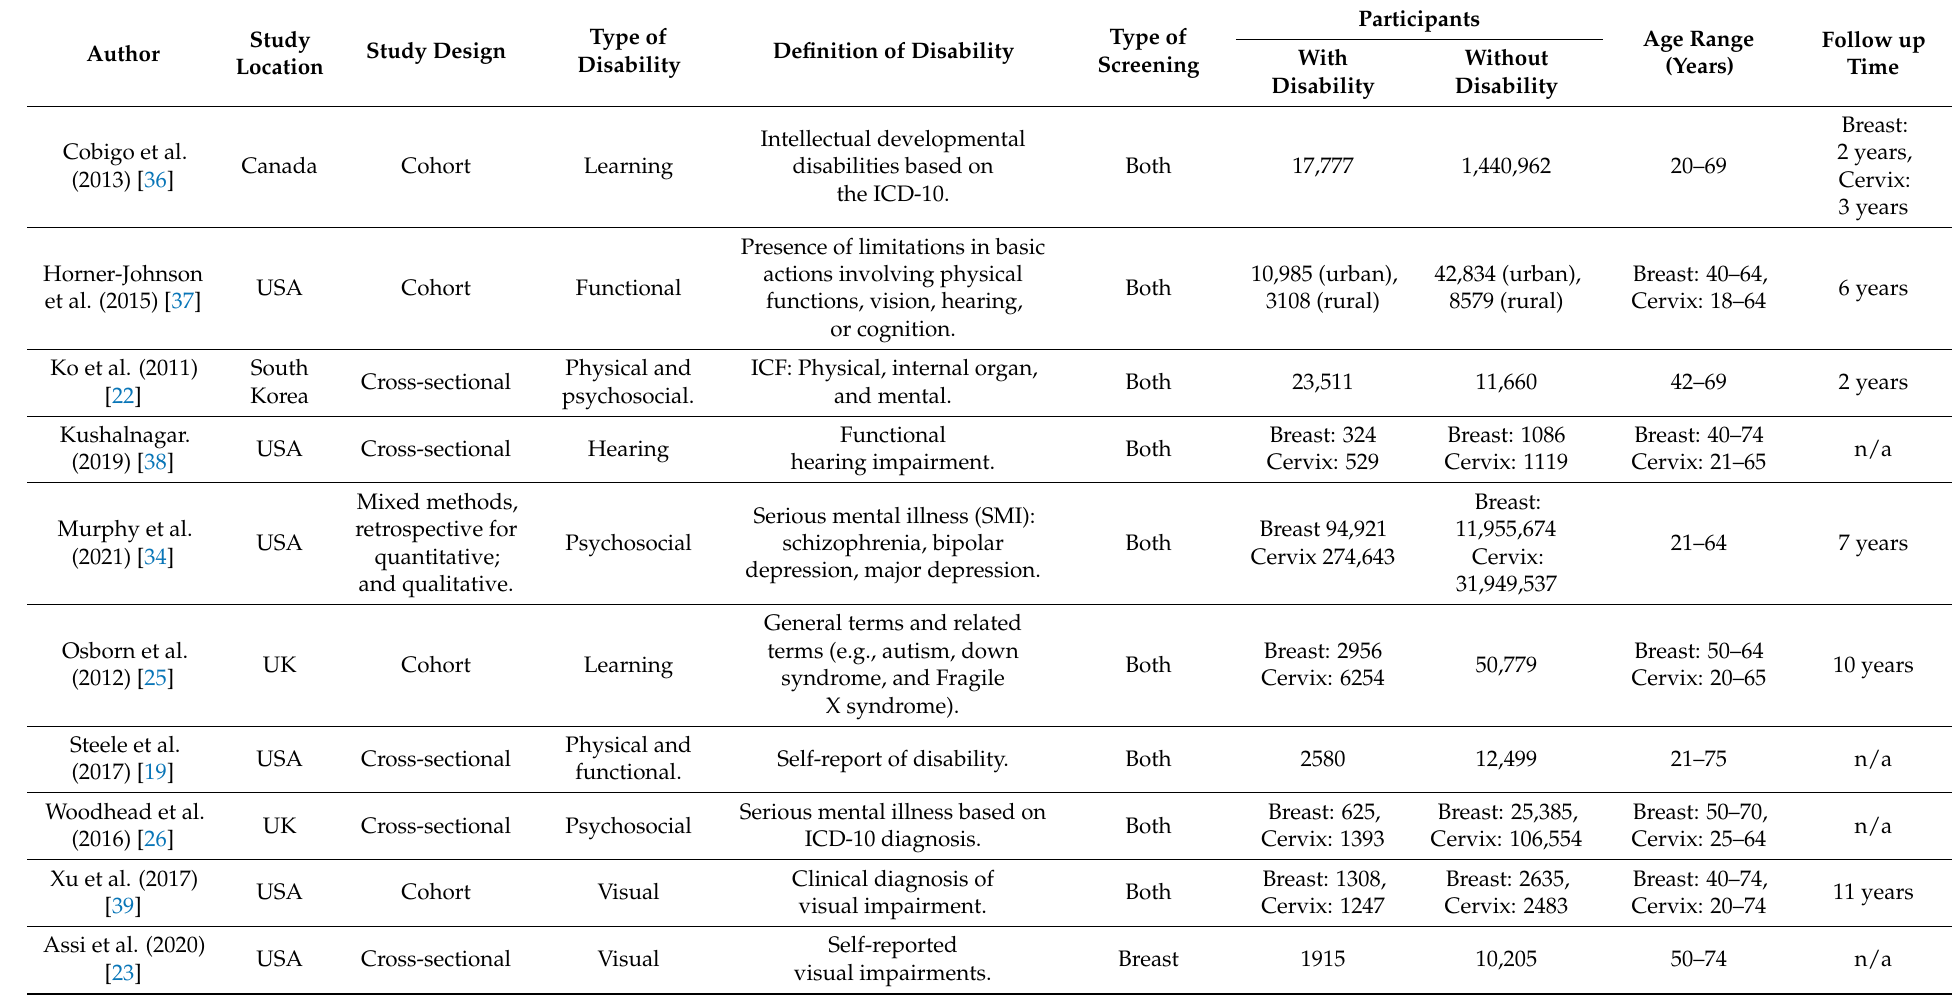
Table 1. Information and characteristics of included